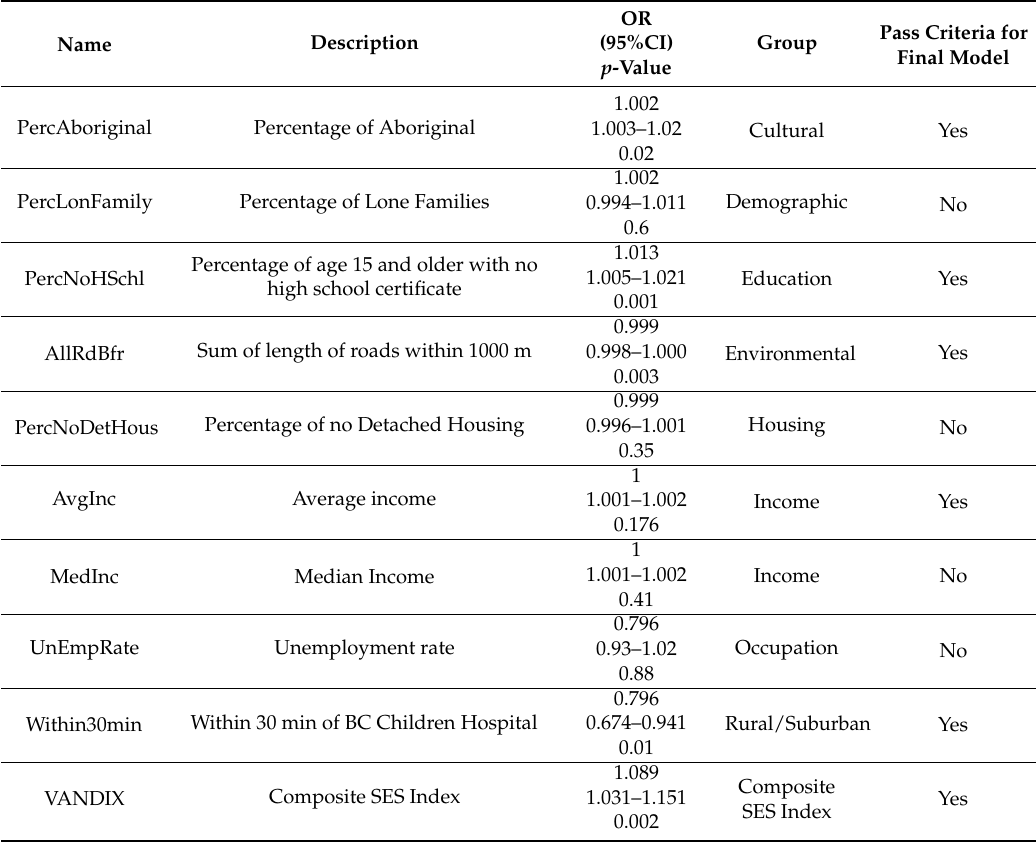
Table 3. List of variables considered for the final model. Only SES variables with p ď 0.2 were used as potential variables in the final model.